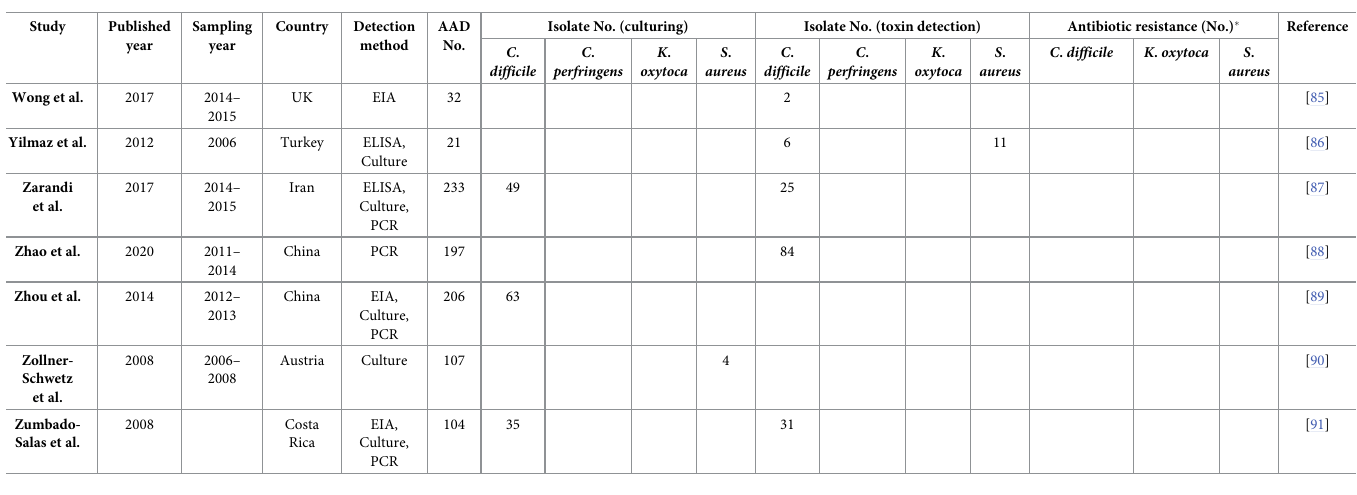
Bacterial prevalence in AAD patients C . difficile prevalence in AAD patients. Regardless the detection method, 52 studies were applied for meta-analysis, in which the pooled prevalence of C . difficile in AAD patients was 19.6% (CI 95%: 15.1–25.1). Considering culturing method, 24 studies